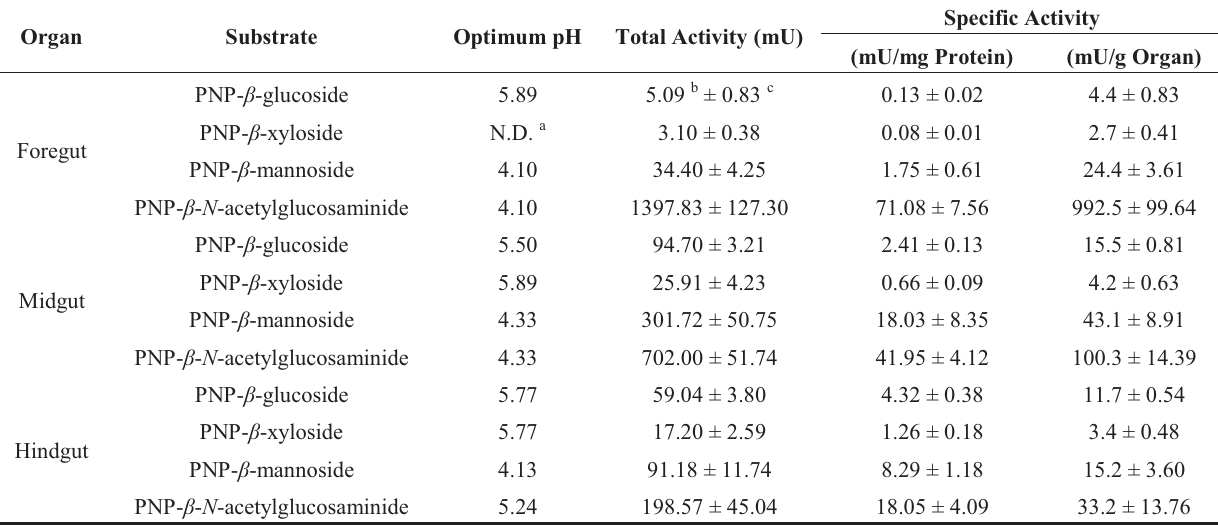
Table 2. Glycosidase activities from the larval digestive tract of the T. dichotomus.